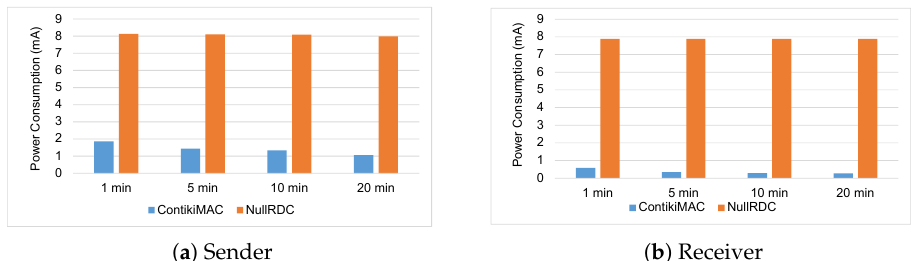
Figure 11. Power consumption of the sensor node based on first